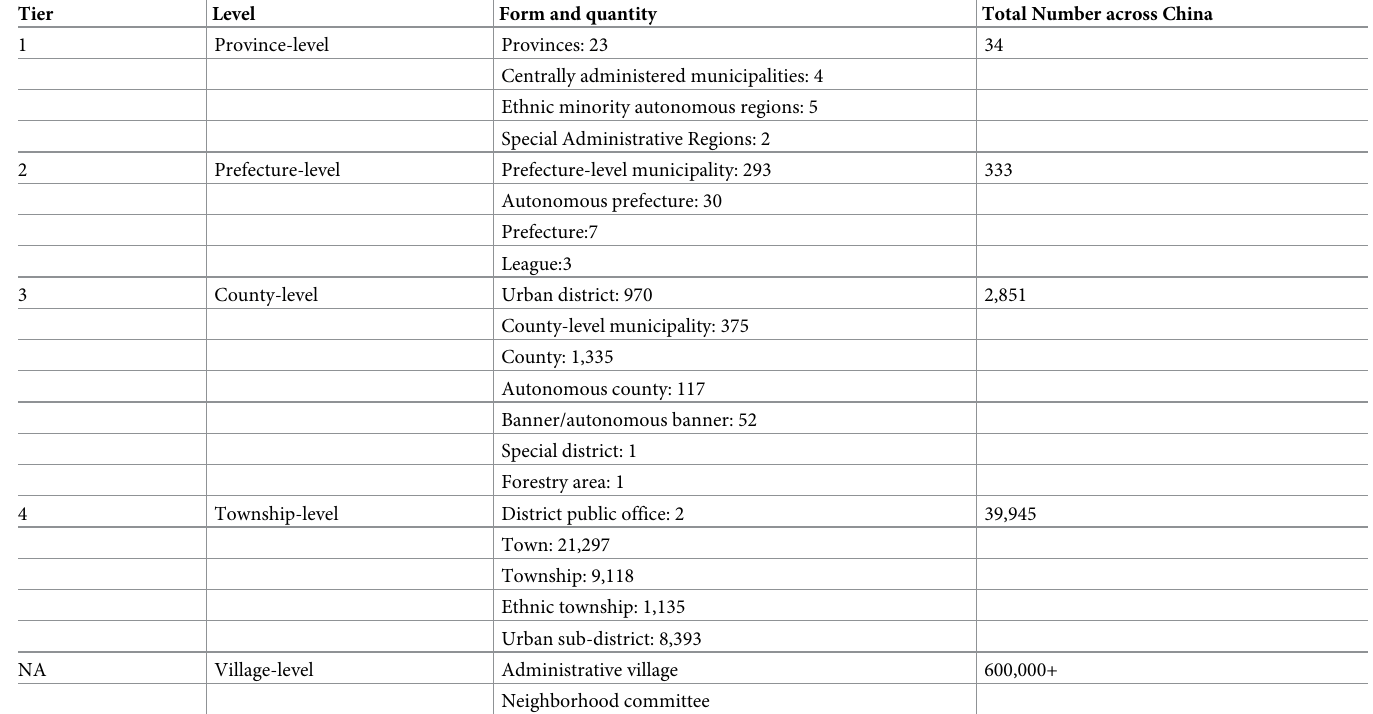
Table 1. Structure of China’s administrative divisions (Ministry of Civil Affairs,